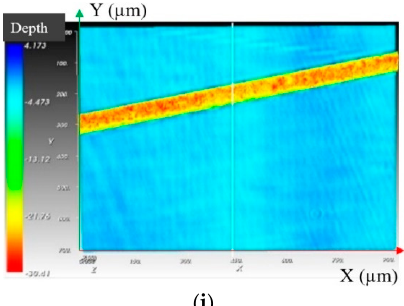
Figure 11. Measurement results of the tested wafer sample shown in Figure 1: ( a ) captured deformed fringe image of specular light, ( b ) captured deformed fringe image of diffuse light, ( c ) wrapped phase map of ( b , d ) wrapped phase map of ( c , e ) reconstructed cross-section of ( c , f ) reconstructed cross-section of ( d , g ) reconstructed 3-D map of the smooth wafer surface, ( h ) reconstructed 3-D map of the laser-etched groove surface, and ( i ) reconstructed 3-D shape of the whole tested wafer surface.